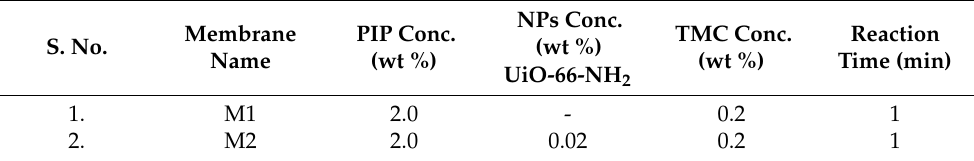
Table 1. Datasheet of the composition of prepared TFC (thin-film composite) and TFN (thin-film nanocomposite)